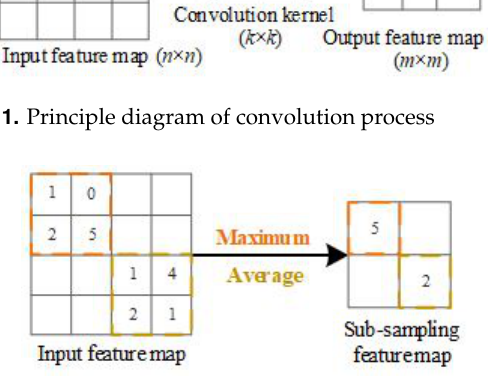
Fig. 2. Principle diagram of pooling